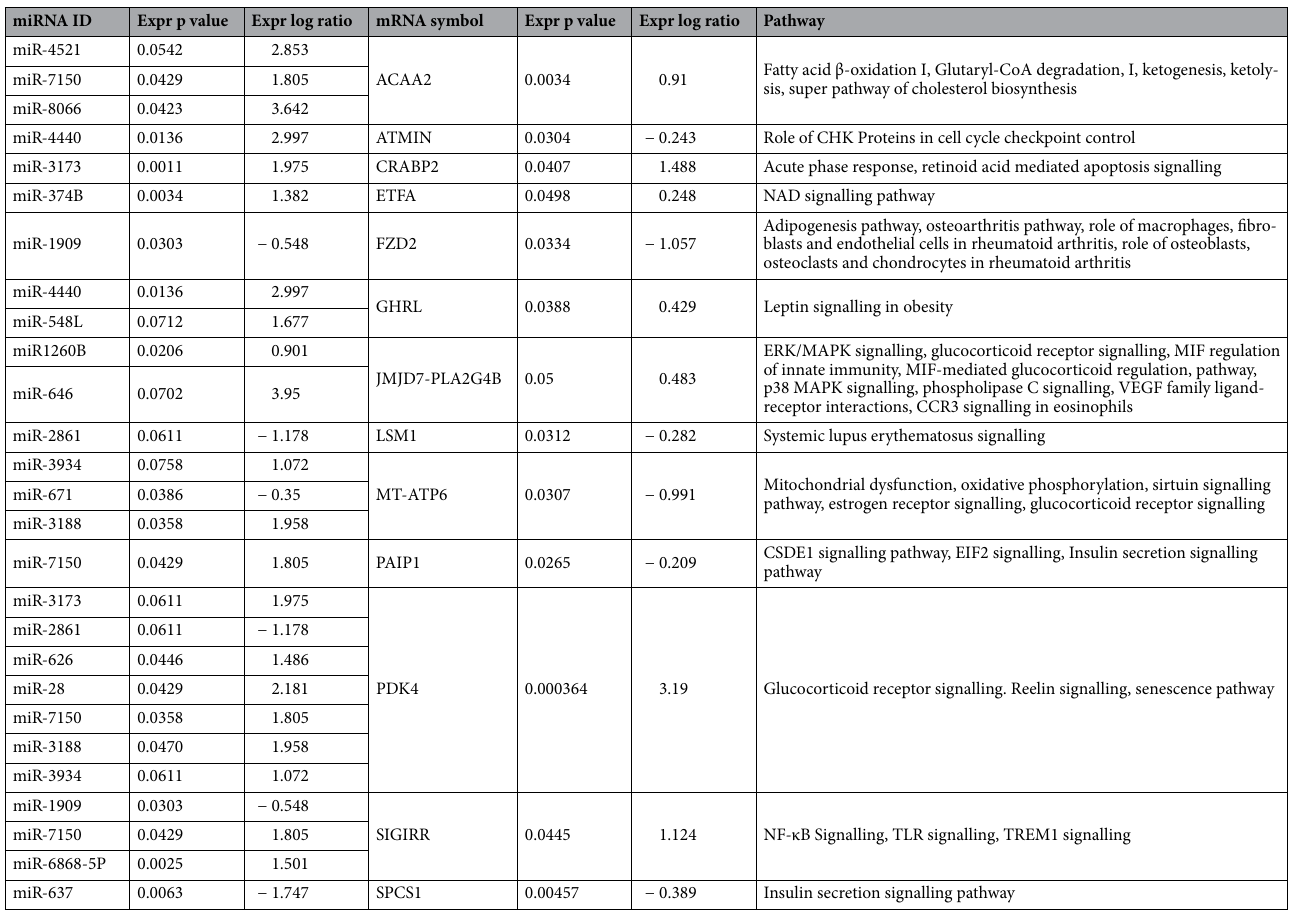
Table 1. Selected miRNAs target mRNA and the relevant associated pathways as per IPA